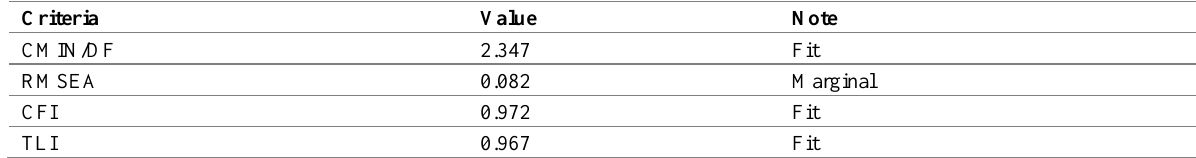
Table 3: Goodness of Fit Results